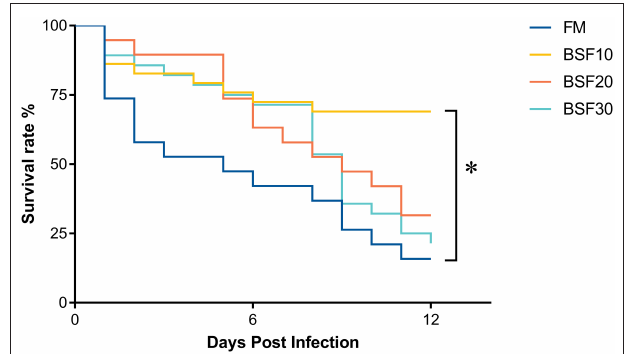
FIGURE 1 | Effect of black soldier fly larvae meal (BSF) on the survival rate of Litopenaeus vannamei after infection of Vibrio parahaemolyticus . Asterisk (*) indicates significantly different ( P < 0.05) among groups based on Tukey’s HSD test.